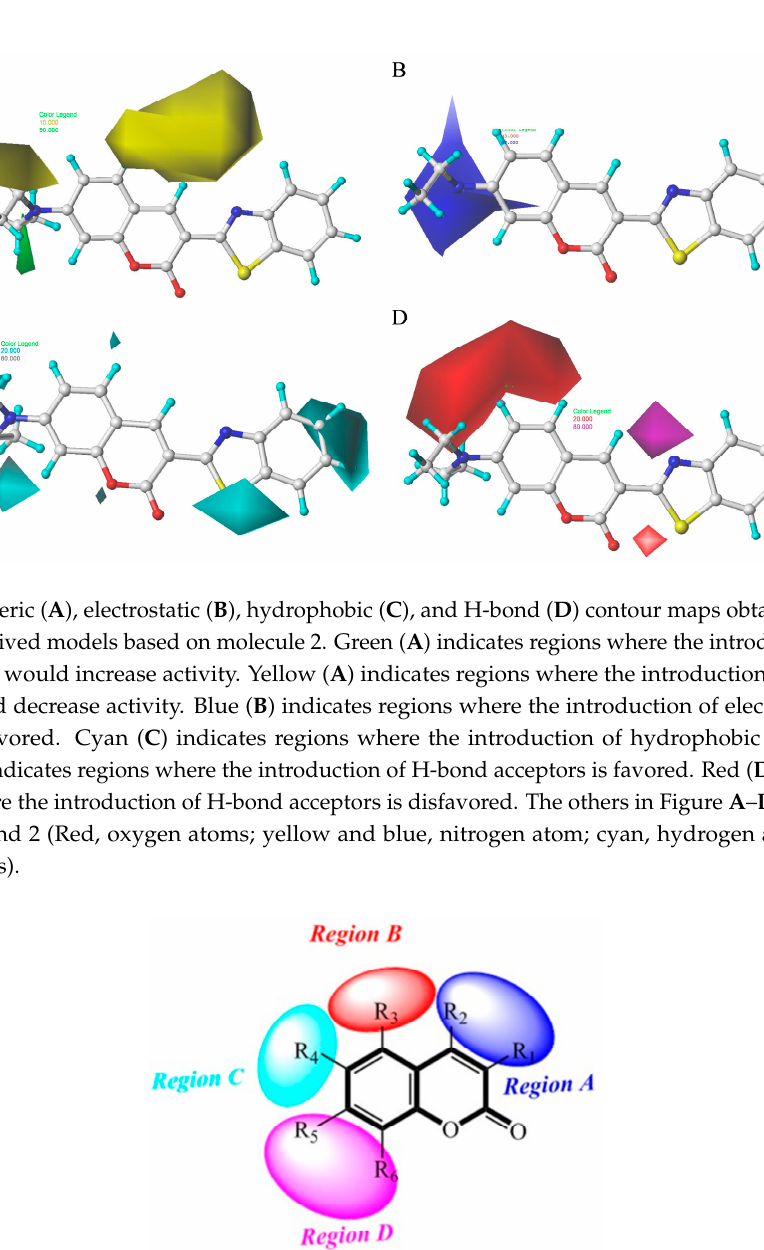
Figure 13. Diagram of structure–activity relationship based on the core structure of the tested compounds. Blue (region A) indicates regions where the introduction of electropositive group, hydrophobic group, or H-accepting groups would increase activity. Red (region B) indicates regions where the introduction of hydrophobic group is favored. Cyan (region C) indicates regions where the introduction of electronegative group is favored. Magenta (region D) indicates regions where the introduction of a bulky group, hydrophobic group, or electropositive group would increase the activity. Dark indicates the core structure of the test compounds.